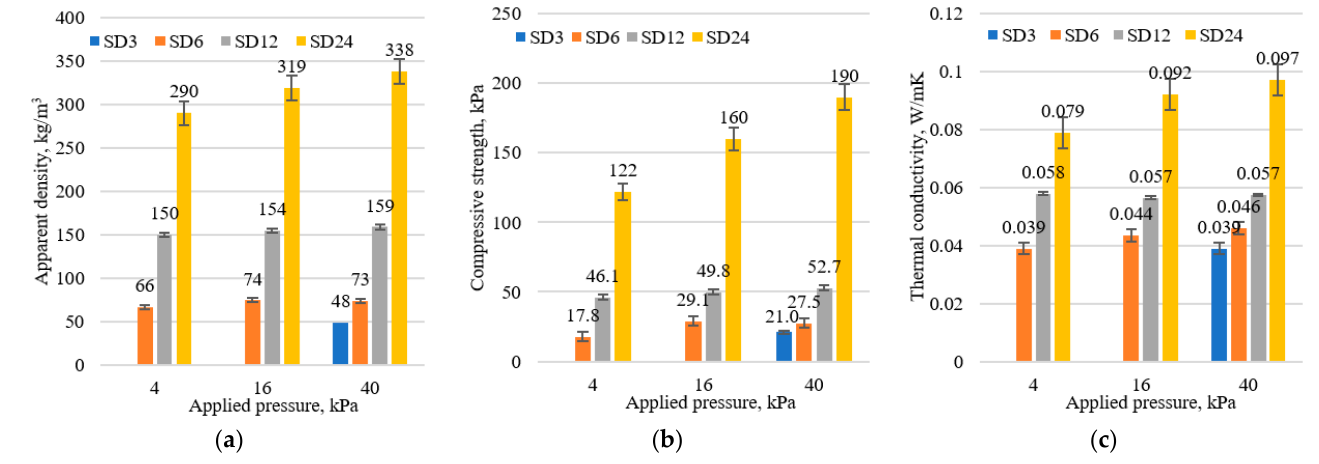
Figure 2. Properties of EPS gypsum composition with different gypsum content and compression pressure: ( a ) Apparent density; ( b ) Compressive strength; ( c ) Thermal conductivity.